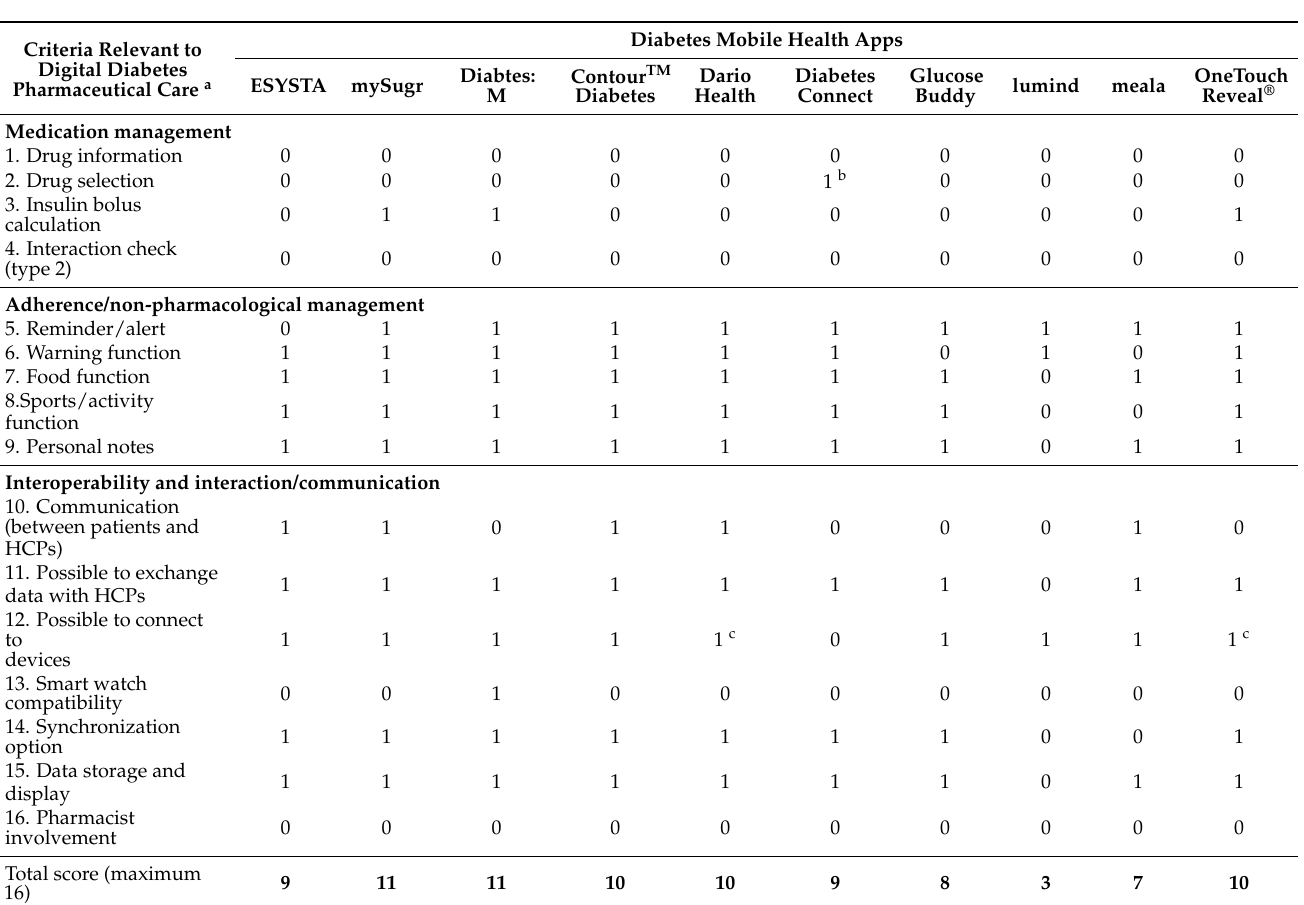
Table 2. Evaluation scores for mobile health apps for diabetes patients based on criteria relevant to digital pharmaceutical care for diabetes